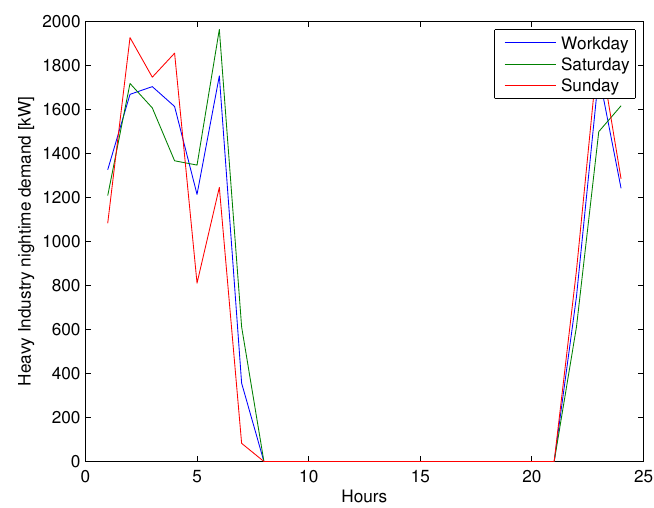
Figure 9. Heavy Industry nighttime curve for three representative days of week.